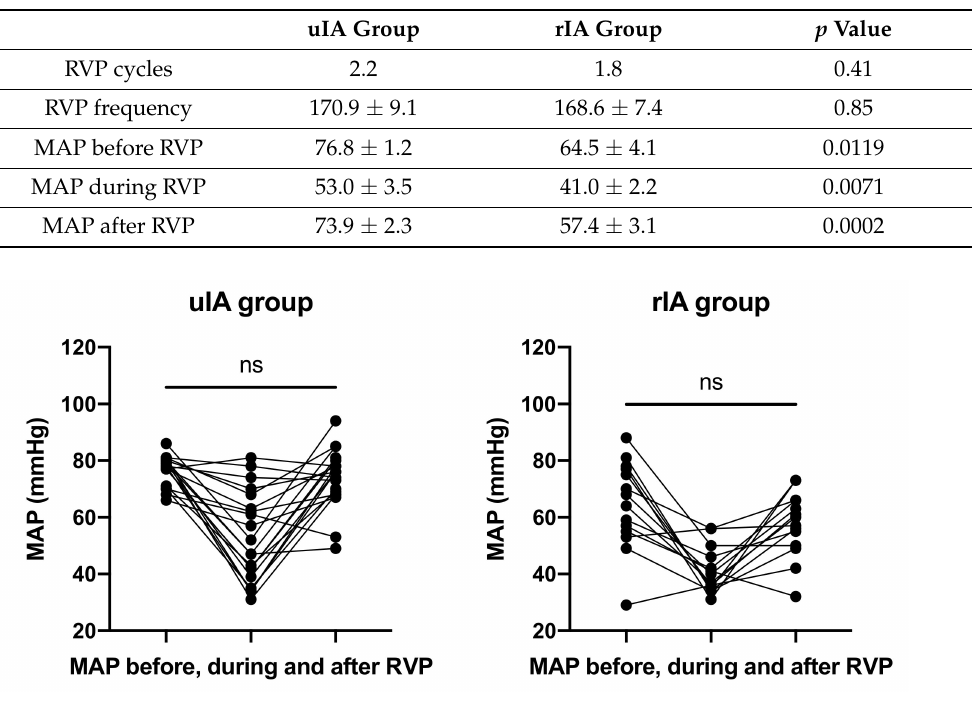
Table 4. Rapid ventricular pacing (RVP) setting and median arterial pressure (MAP) results.